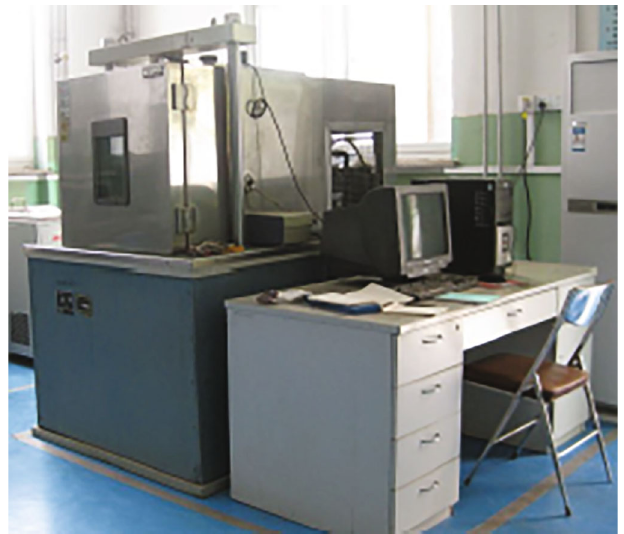
Figure 1: Uncon fi ned compressive strength testing machine for frozen soil.